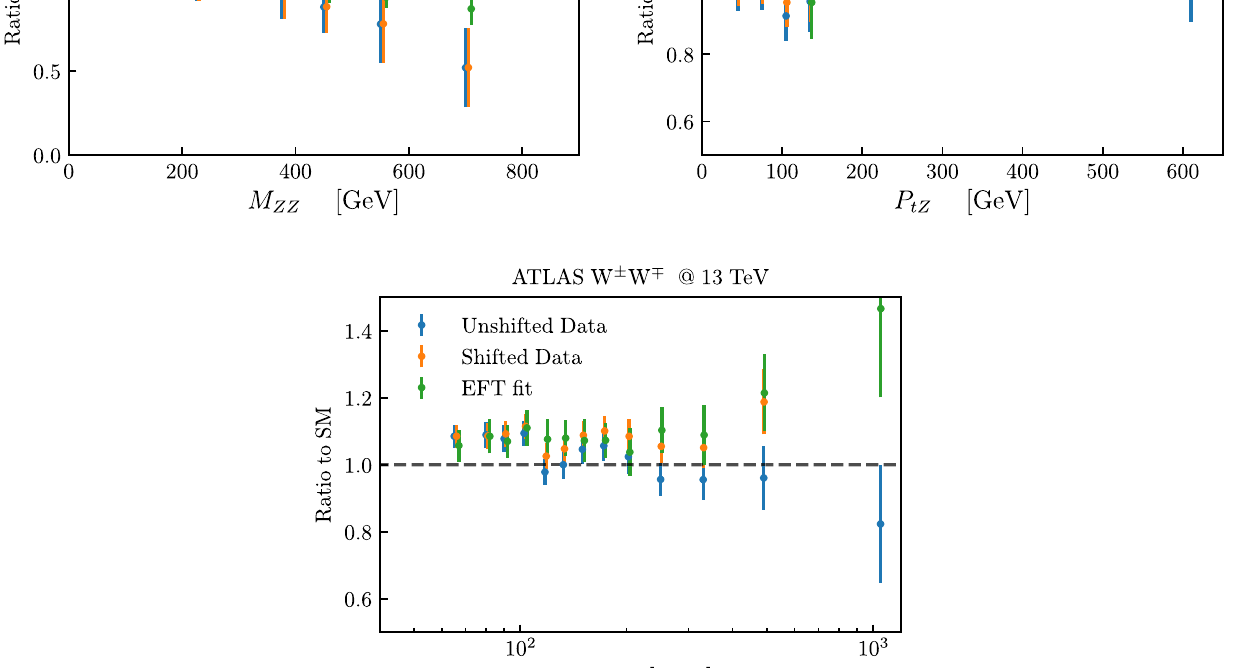
the central value of the SM prediction. The band in the EFT prediction indicates the post-fit 95% CL uncertainty